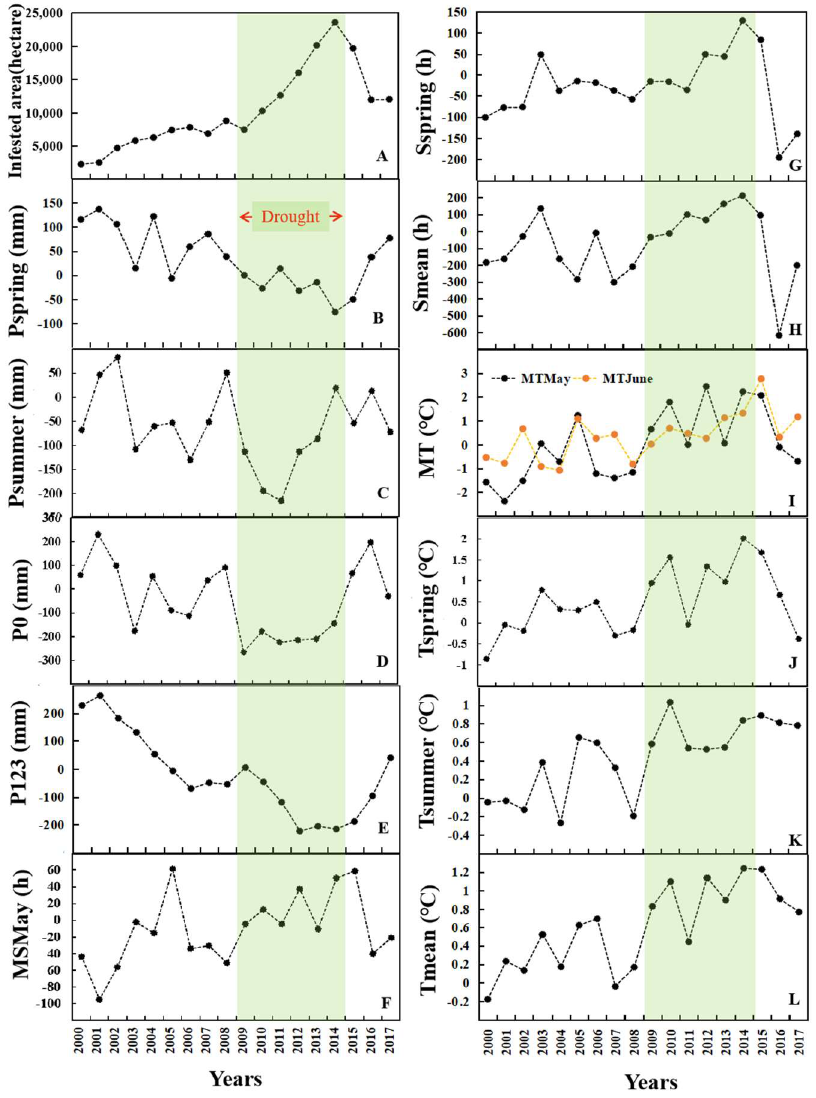
Figure 7. Temporal changes of infested area and climate variables anomalies (differences from mean values calculated from 1971 to 2000) from 2000 to 2017. ( A ): Beetle-infested total area; ( B ): Pspring (Cumulative precipitation between March to May) anomaly; ( C ): Psummer (Cumulative precipitation between June to August) anomaly; ( D ): P0 (Cumulative precipitation in the current year (0)) anomaly; ( E ): P123 (Cumulative precipitation in previous 1–3 years) anomaly; ( F ): MSMay (Mean solar radiation duration in May) anomaly; ( G ): Sspring (Cumulative solar radiation duration between March to May) anomaly; ( H ): Smean (Annual cumulative solar radiation duration) anomaly; ( I ): MTMay (Mean temperature in May); MTJune (Mean temperature in June) anomaly; ( J ): Tspring (Mean temperature between March to May) anomaly; ( K ): Tsummer (Mean temperature between June to August) anomaly; and ( L ): Tmean (Annual mean temperature)